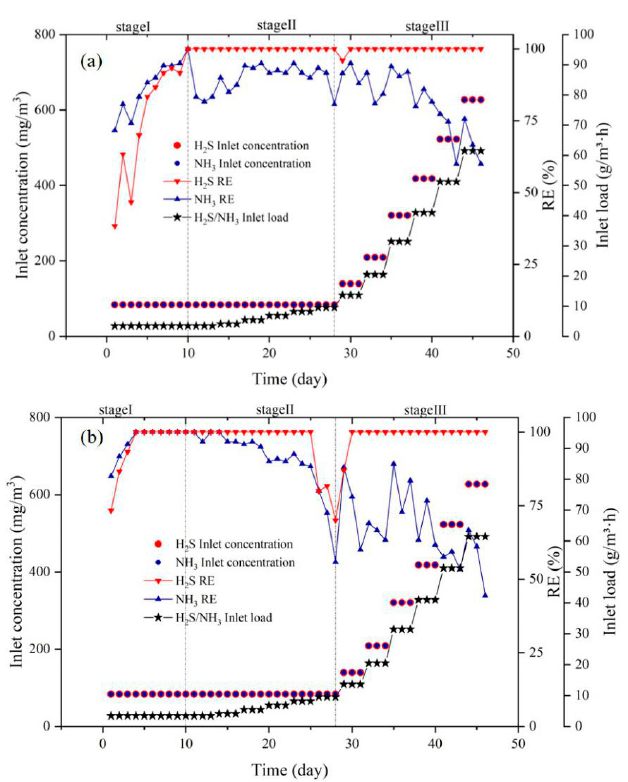
Figure 4. Removal efficiency of H 2 S and NH 3 in BTF1 ( a ) and BTF2 ( b ) under different inlet concen- tration and EBRT